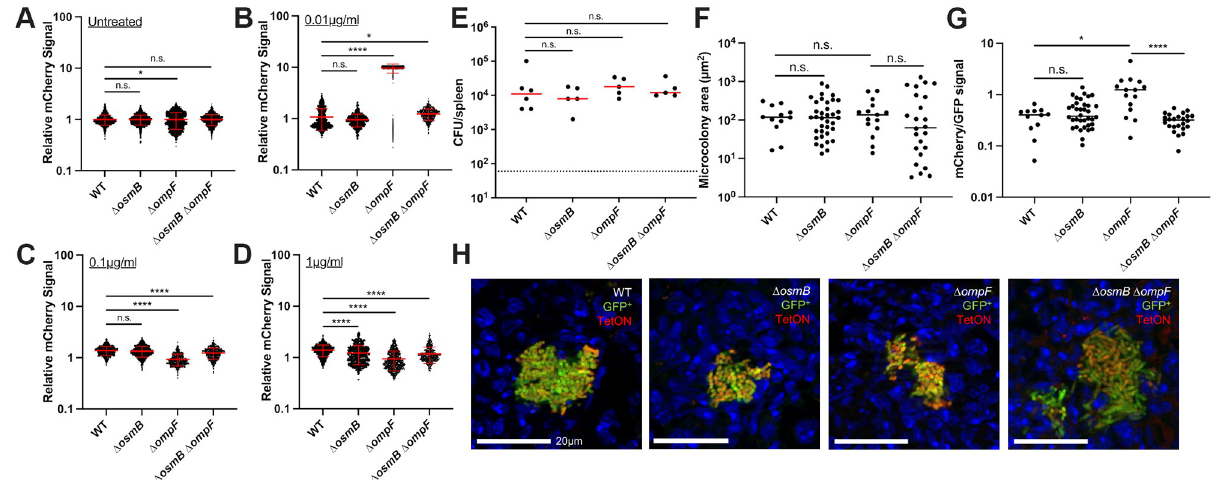
Fig 5. Δ ompF has altered doxycycline permeability. (A-D) WT and deletion strains ( Δ osmB , Δ ompF , Δ osmB Δ ompF ) transformed with the constitutive GFP plasmid and TetON reporter plasmid were incubated with the indicated concentrations of Dox for 4h. mCherry fluorescence was detected within individual cells by fluorescence microscopy. Relative mCherry was calculated by normalizing to the WT untreated average cell value. Data represents the mean and standard deviation of three biological replicates. (E) C57BL/6 mice were infected with WT or mutant strains (GFP + TetON). Infections proceeded 48h, and mice were injected intraperitoneally with a single dose of Dox. Spleens were harvested 24h after treatment to (E) quantify CFUs, (F) quantify microcolony areas, and (G) quantify reporter signal by fluorescence microscopy. Relative reporter signal was quantified by dividing the mean mCherry (TetON) signal by the mean GFP signal from each microcolony. 5 mice were quantified/strain, and 1–15 microcolonies were quantified in one section for each mouse. (H) Representative images, scale bars: 20 μ m. All mouse experiments were carried out on two independent days. Statistics: Kruskal-Wallis one-way ANOVA with Dunn’s post-test. ���� p < .0001, � p < .05, n.s.: not significant.